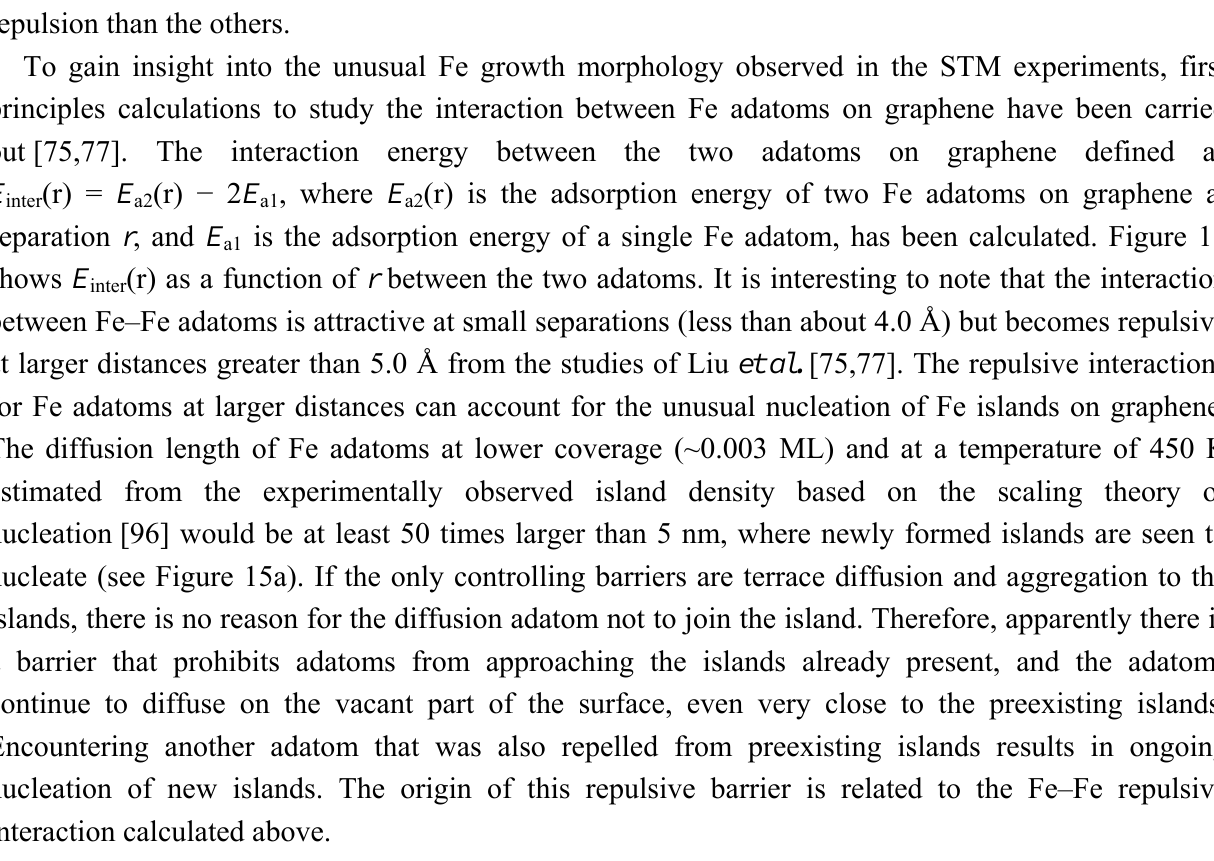
(small open symbols) e